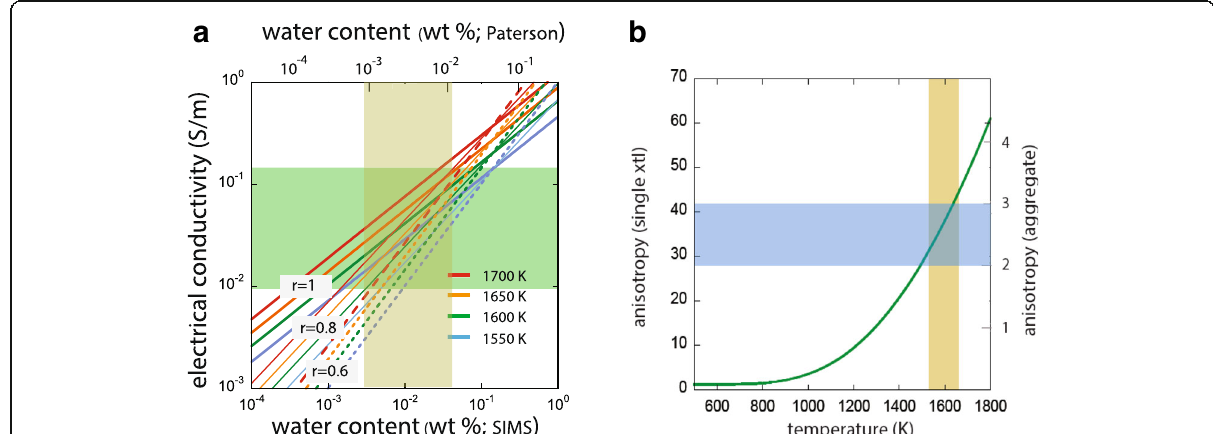
Fig. 11 Testing the hydrogen-assisted conductivity model against geophysical observations on the asthenosphere (after Dai and Karato 2014b). a The water content-temperature combinations that explain geophysically inferred conductivity of then asthenosphere (green region is the conductivity of the asthenosphere, brown region is water content of the asthenosphere). b Anisotropy in electrical conductivity. “ 0 ” anisotropy means isotropic. “ 3 ” means a factor of 3